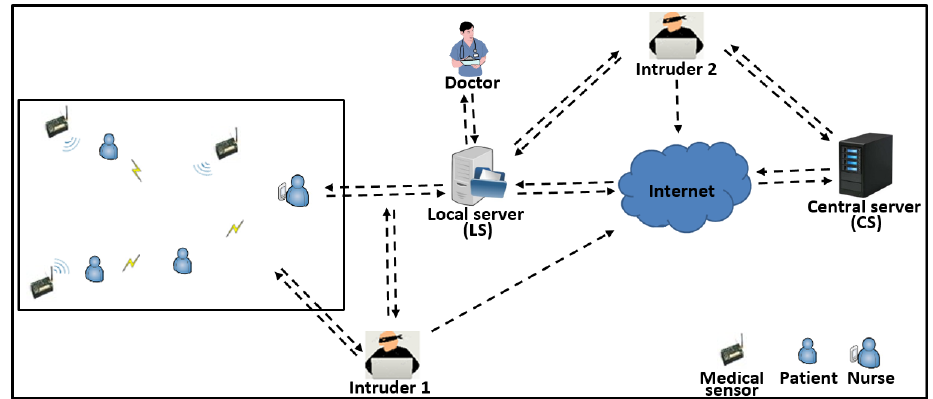
Figure 1. An attack on communication security (Intruder 1) and datasets security (Intruder